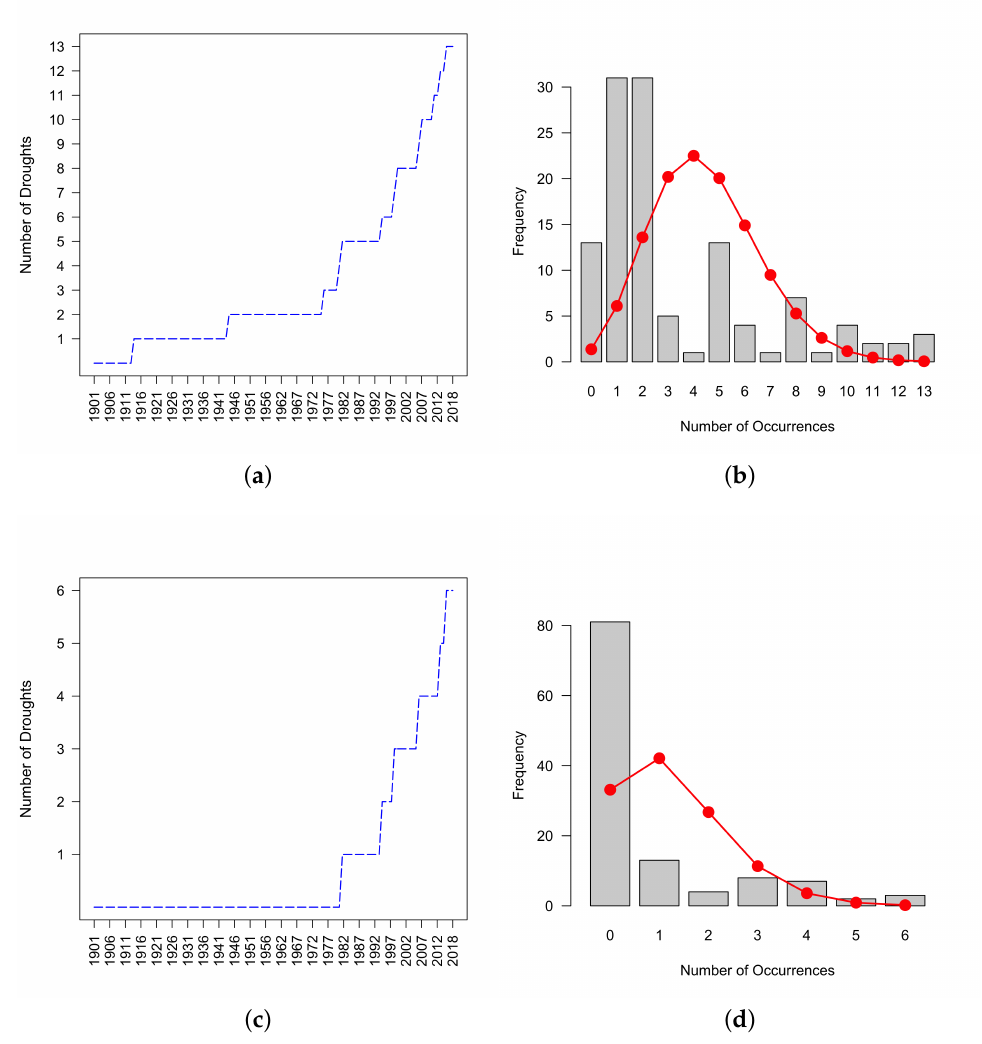
Figure 3. Cumulated function of episodes identified by SPEI-6 for the month of March in the period 1901–2018 at location 37.00 ◦ N, 2.25 ◦ W of Iberian peninsula and the correspondent fit of count data to the Poisson distribution: ( a , b ) Drought class; and ( c , d ) Severe+Extreme